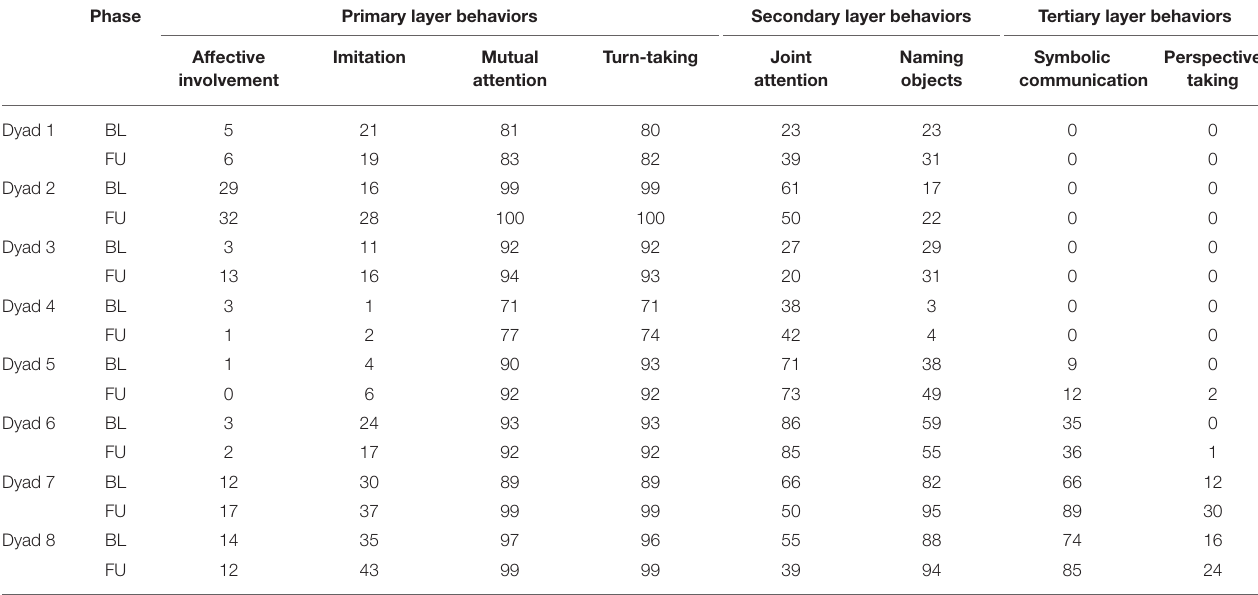
TABLE 11 | Mean percentage of presence for each LCM behavior during baseline (BL) and follow-up (FU) recordings. Phase Primary layer behaviors Secondary layer behaviors Tertiary layer behaviors Affective Imitation Mutual Turn-taking Joint Naming Symbolic Perspective involvement attention attention objects communication